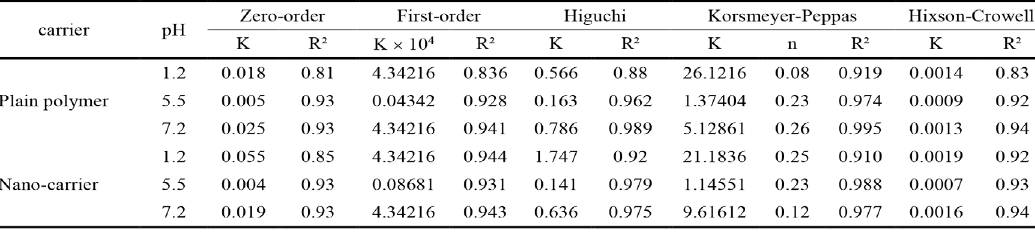
Table 4. The correlation coefficient and kinetic rate constants of different kinetic